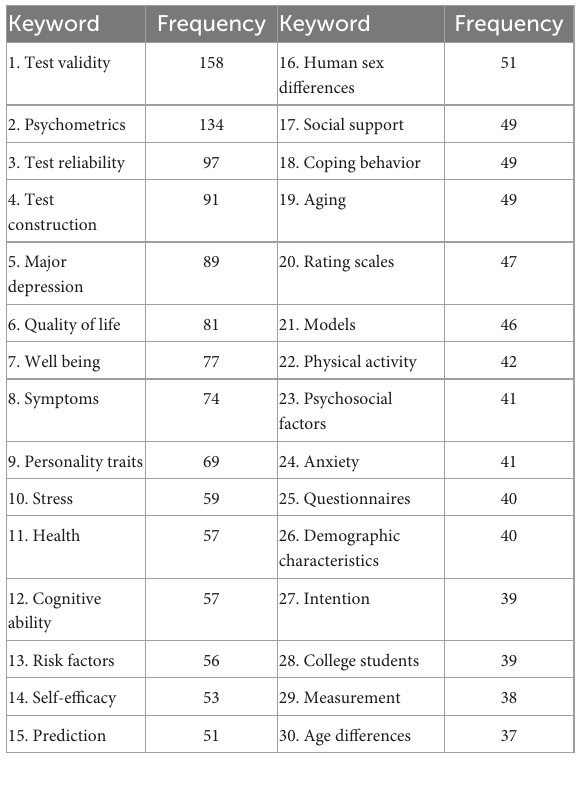
TABLE 2 The 30 most frequent keywords in the included articles with frequencies of